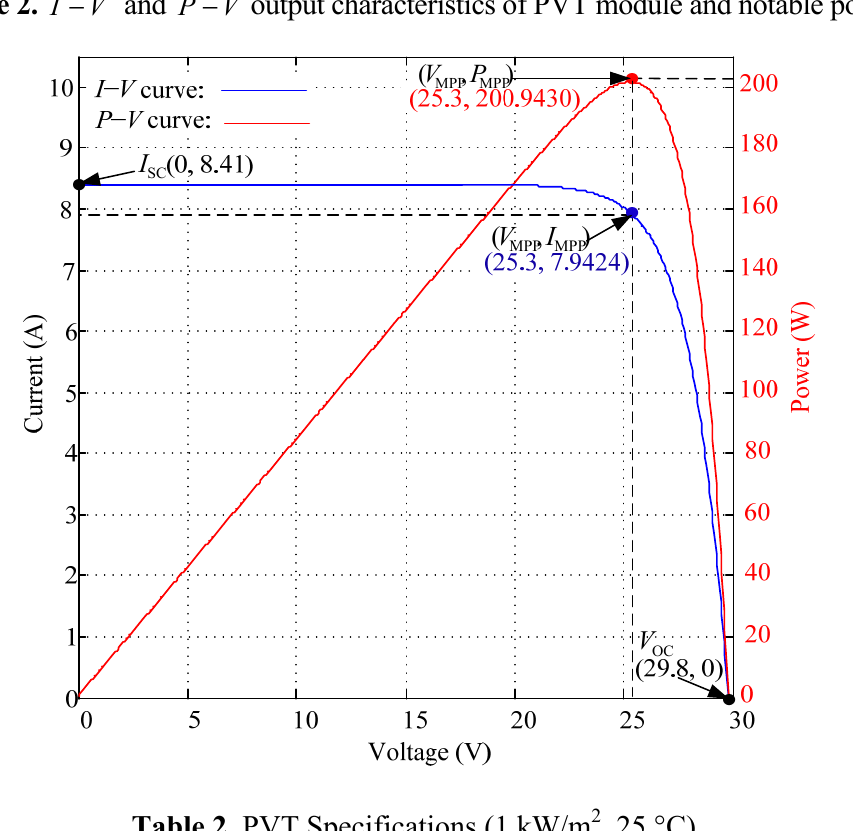
Figure 2. VI − and VP − output characteristics of PVT module and notable points.